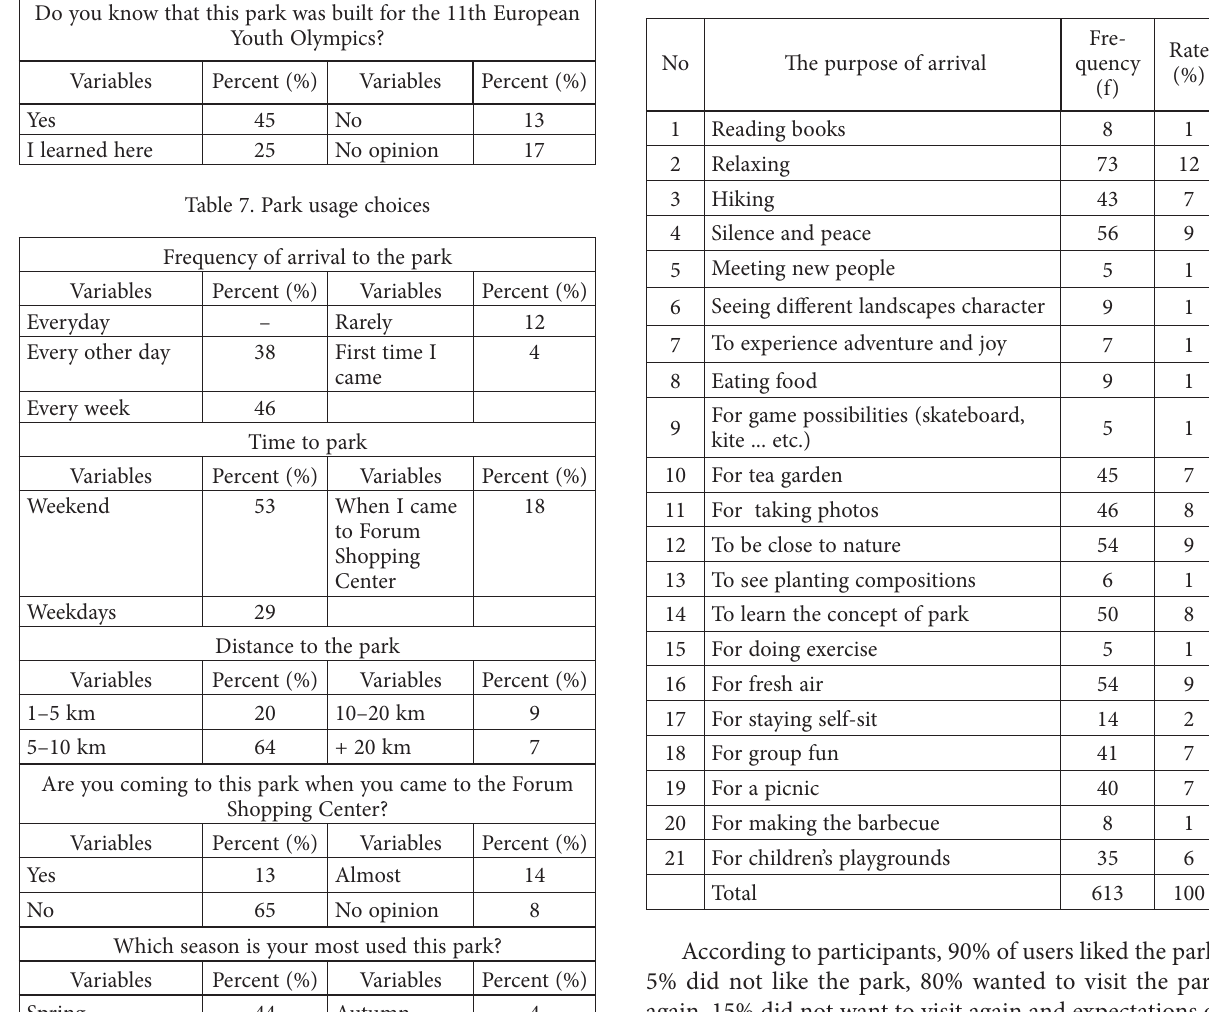
Table 8. Purpose of park